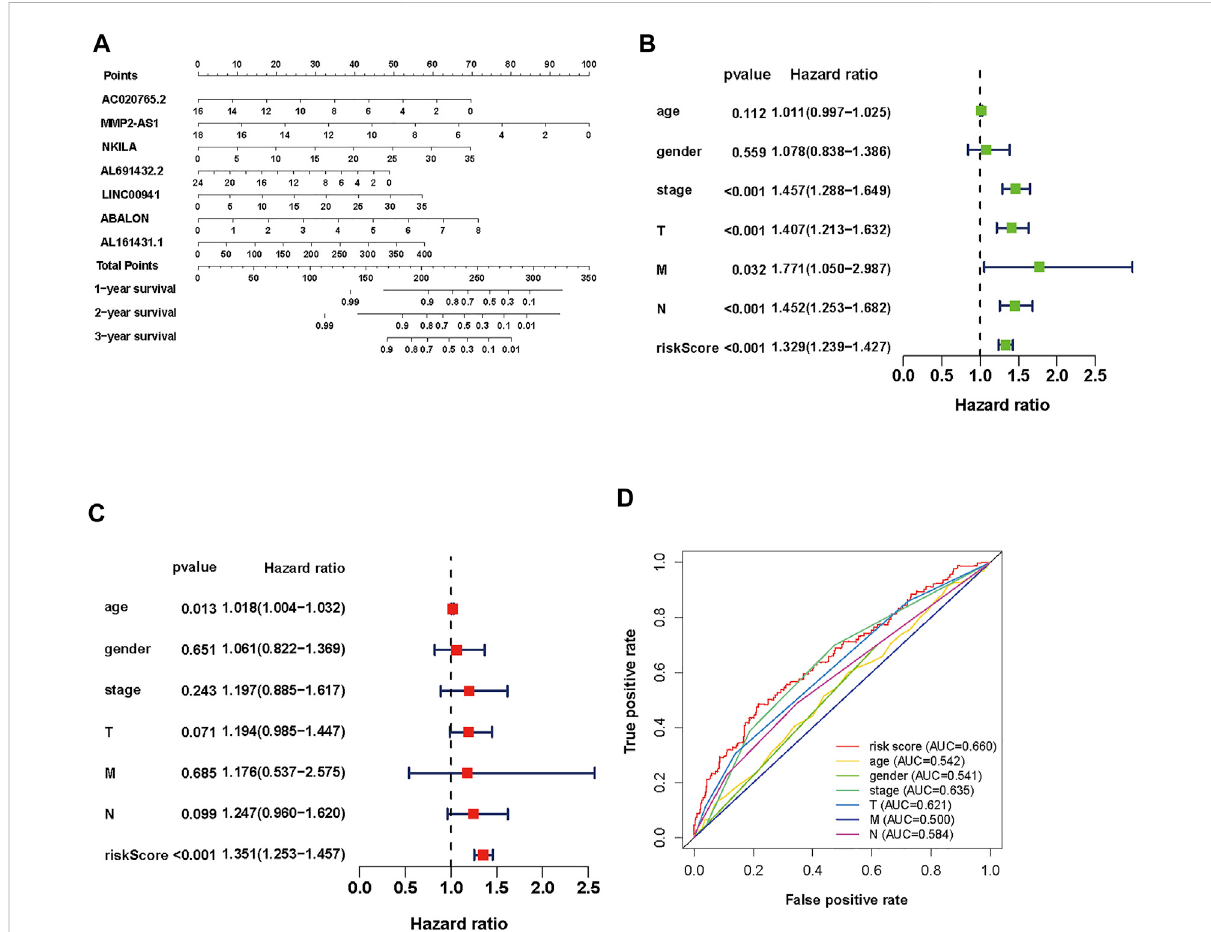
FIGURE 4 Evaluation of the prognostic risk model of the 7 autophagy-associated lncRNAs in NSCLC. (A) Nomogram of the 7 autophagy-associated lncRNAs. (B,C) The univariate (B) and multivariate (C) Cox analysis of risk score model and clinical features. (D) The ROC curve analysis displays the prognostic accuracy of clinical features such as age, gender, T stage, M stage, N stage, and risk